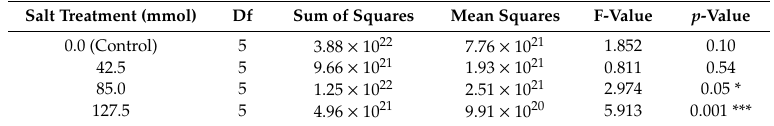
Table 1. The e ff ect of salt treatment levels on six genotypes based on a one-way ANOVA. Salt Treatment (mmol) Df Sum of Squares Mean Squares